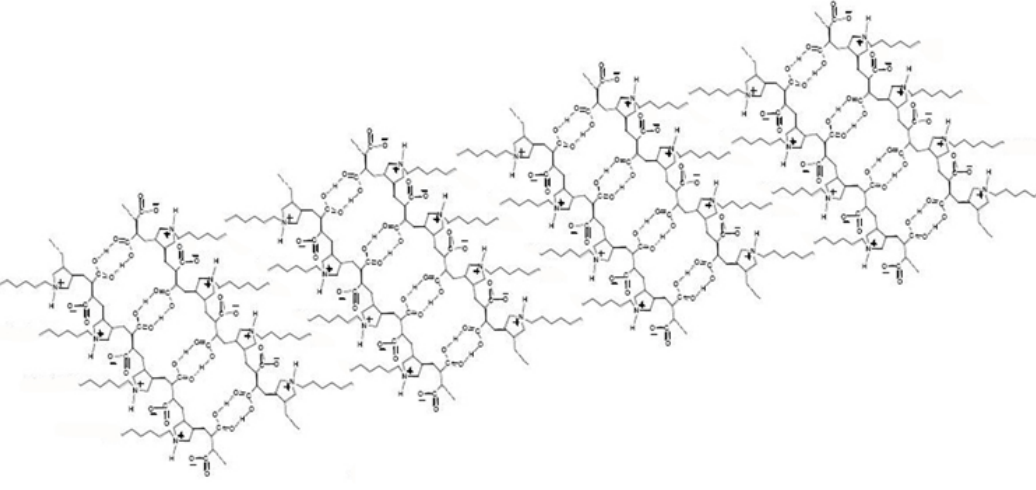
-H polymer matrix. 6